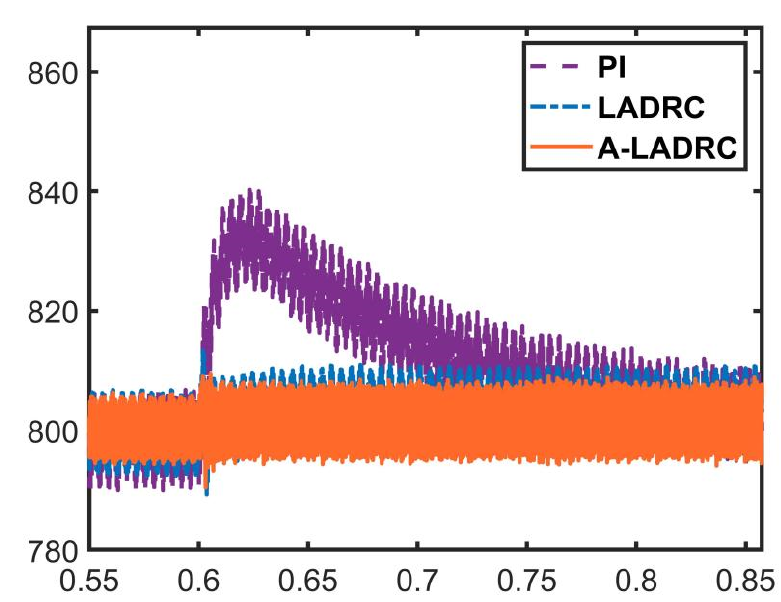
Figure 11. DC bus voltage waveform.